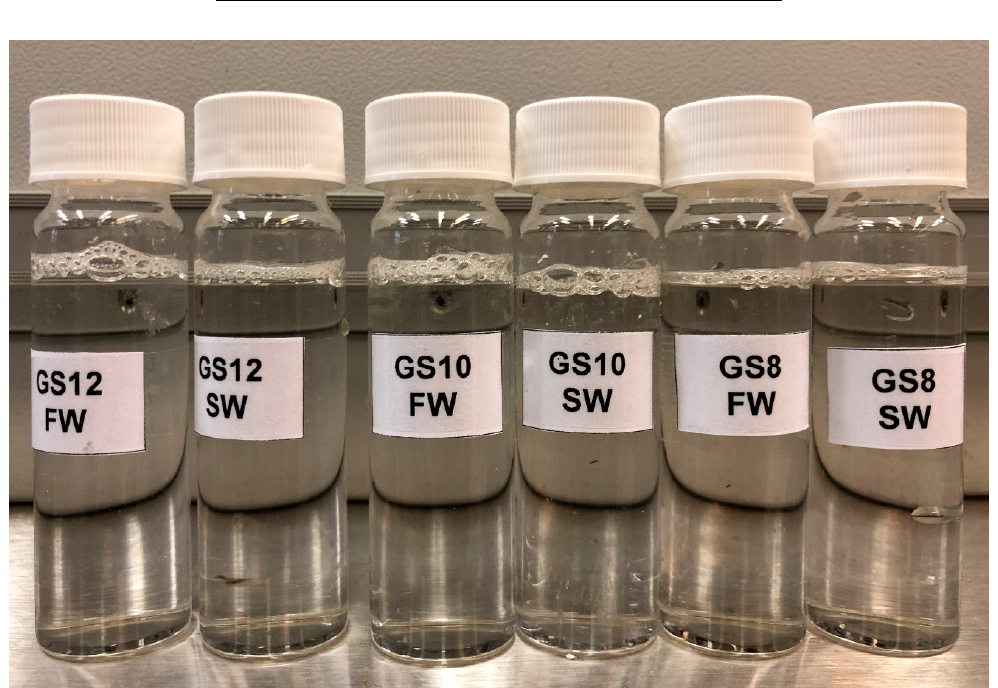
Figure 11. Snapshot of GS8, GS10, and GS12 solutions in reservoir brine (FW) and seawater (SW). Table 5. The amount of salts in simulated FW and SW.